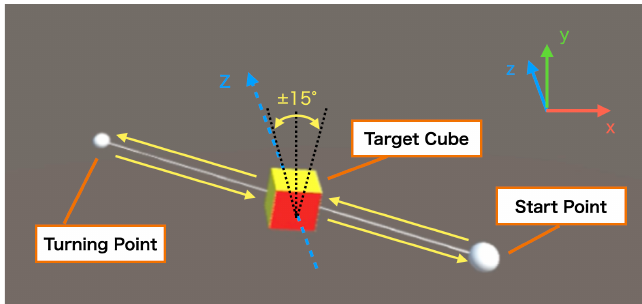
Figure 4. Movement of the target cube: The target cube makes one round trip on a line segment connecting two different points (start point and turning point) in virtual space, taking approximately 15 s. At the same time, the cube repeatedly rotates ± 15 ◦ around the z -axis in 2 s per round